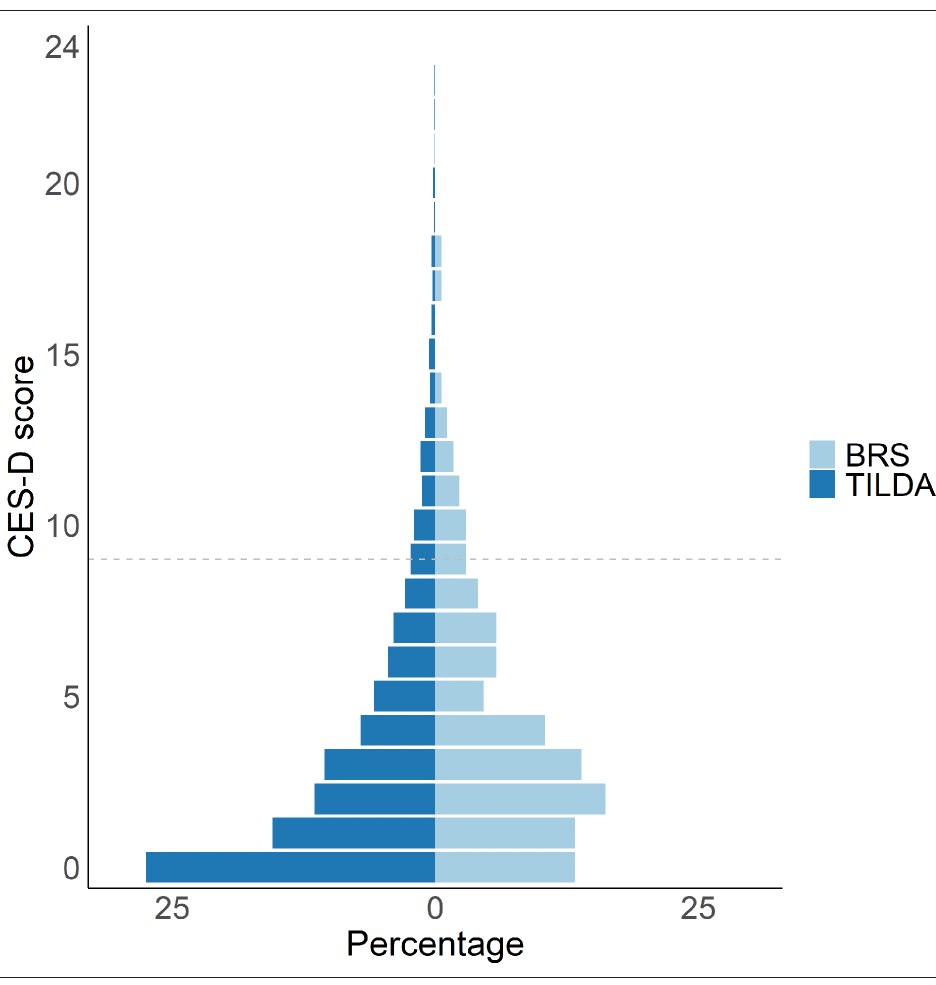
Figure 6: Center for Epidemiological Studies depression (CES-D) score distribution of biodiversity recorders compared with that of older adult population in Ireland using The Irish Longitudinal Study on Ageing (TILDA). A CES-D score of 9 or above indicates clinical depression.